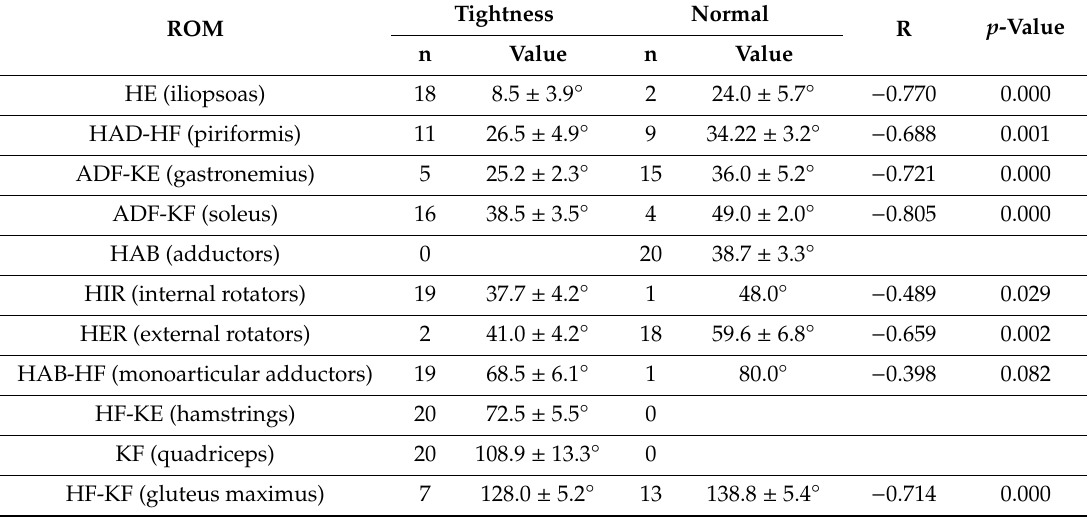
Table 6. Classification of range of motion values (normal versus tightness) of the non-dominant limb in the 20 inline hockey players of the Spanish elite male and female national